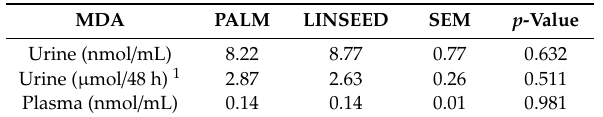
Table 4. Concentration of malondialdehyde (MDA) in urine and plasma of rabbits from di ff erent experimental groups (average).